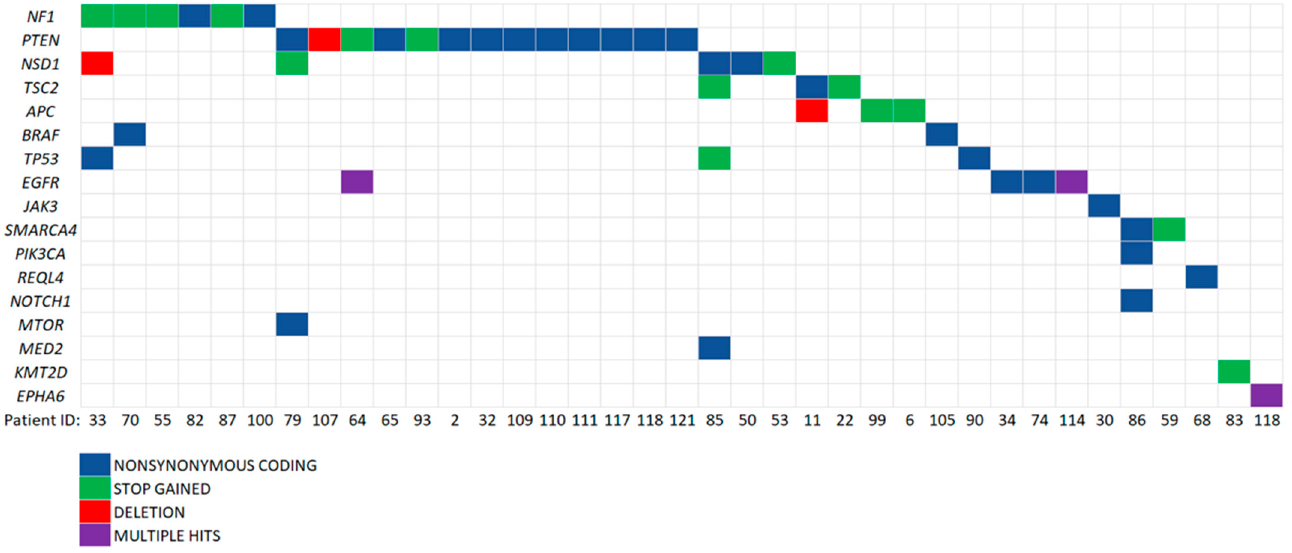
Figure 7. Detailed and schematic representation of genetic variants found in ccfDNA, but not in gDNA of brain tumor patients.